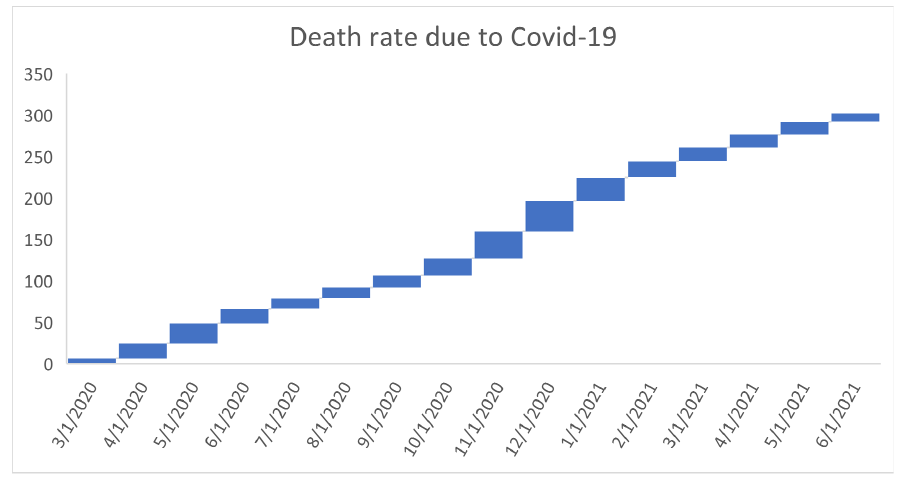
Figure 6. Progressive death rates n US. For readability, note that 4/1/2020 refers 1 April 2020.